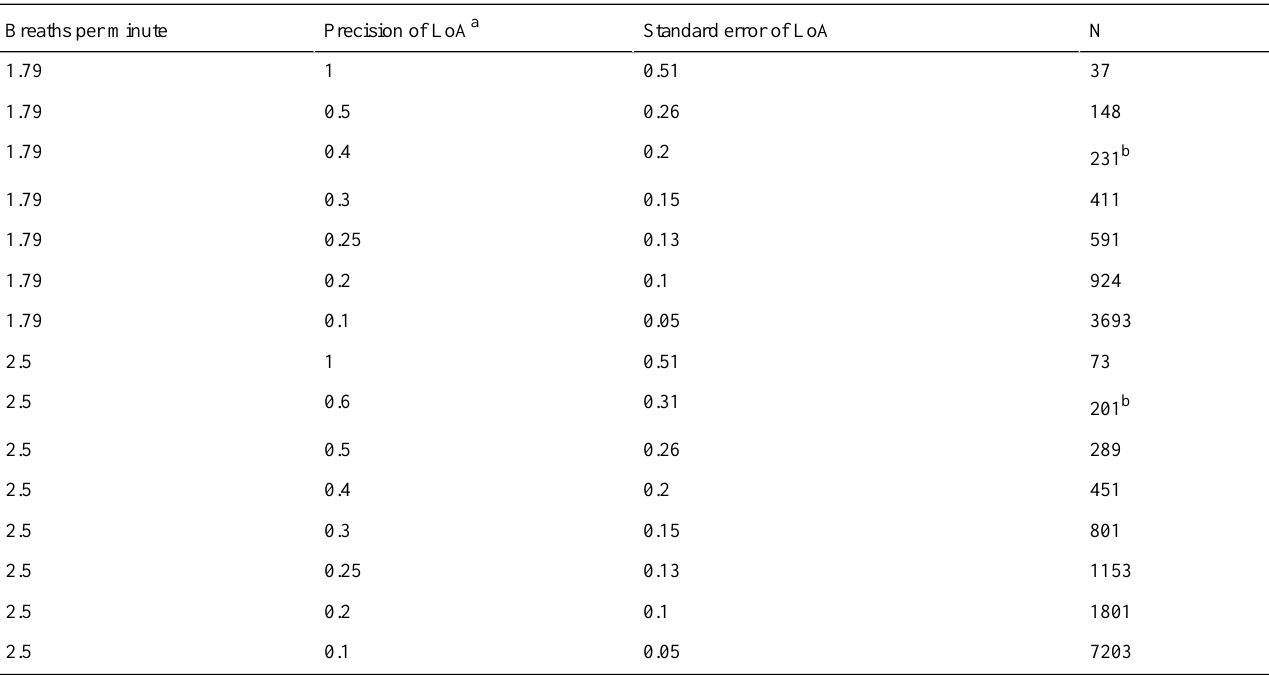
Table 4. Precision of limits of agreement at 95% confidence